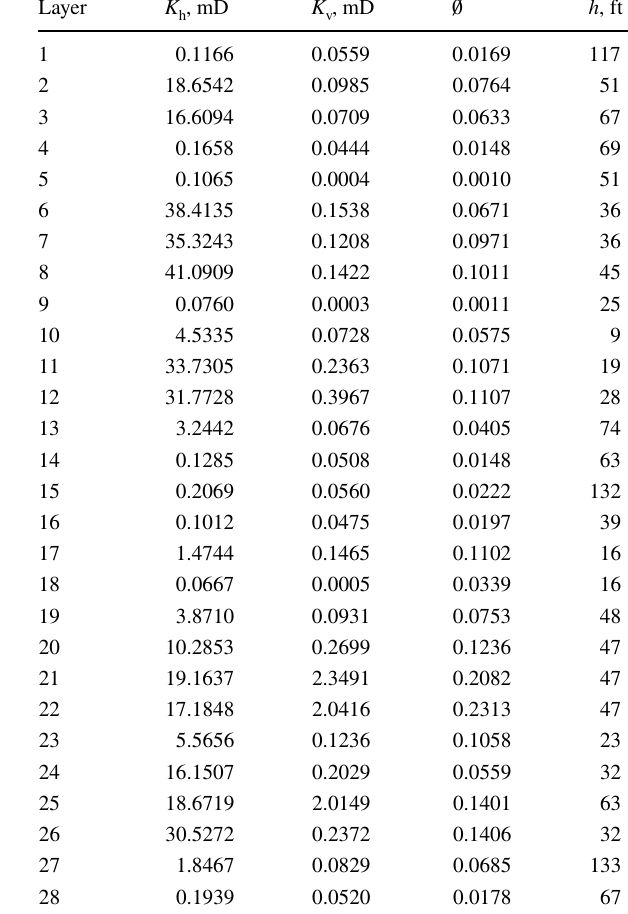
Table 2 Petrophysical specification of reservoir